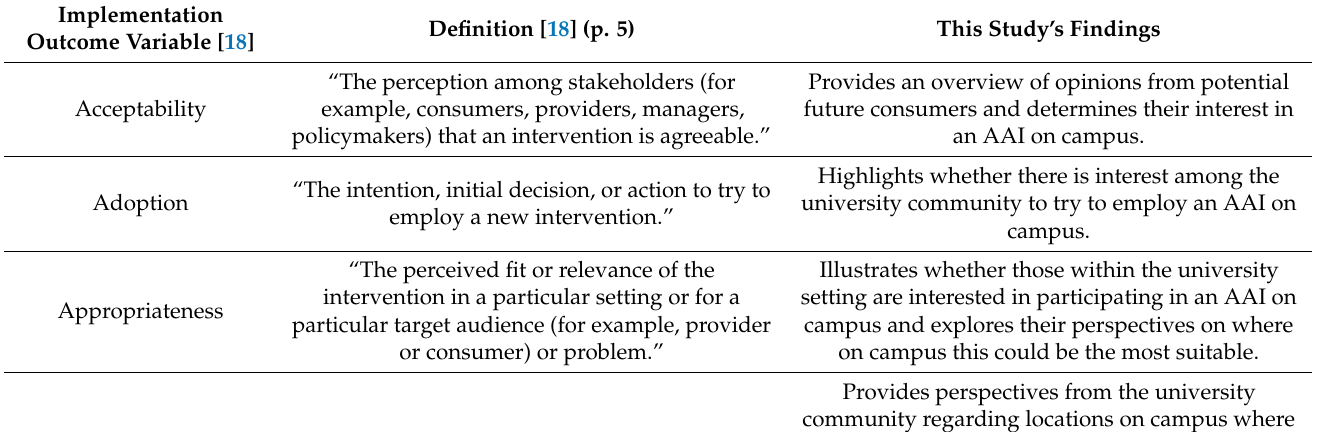
Table 5. study’s alignment with the Implementation Outcome Variables